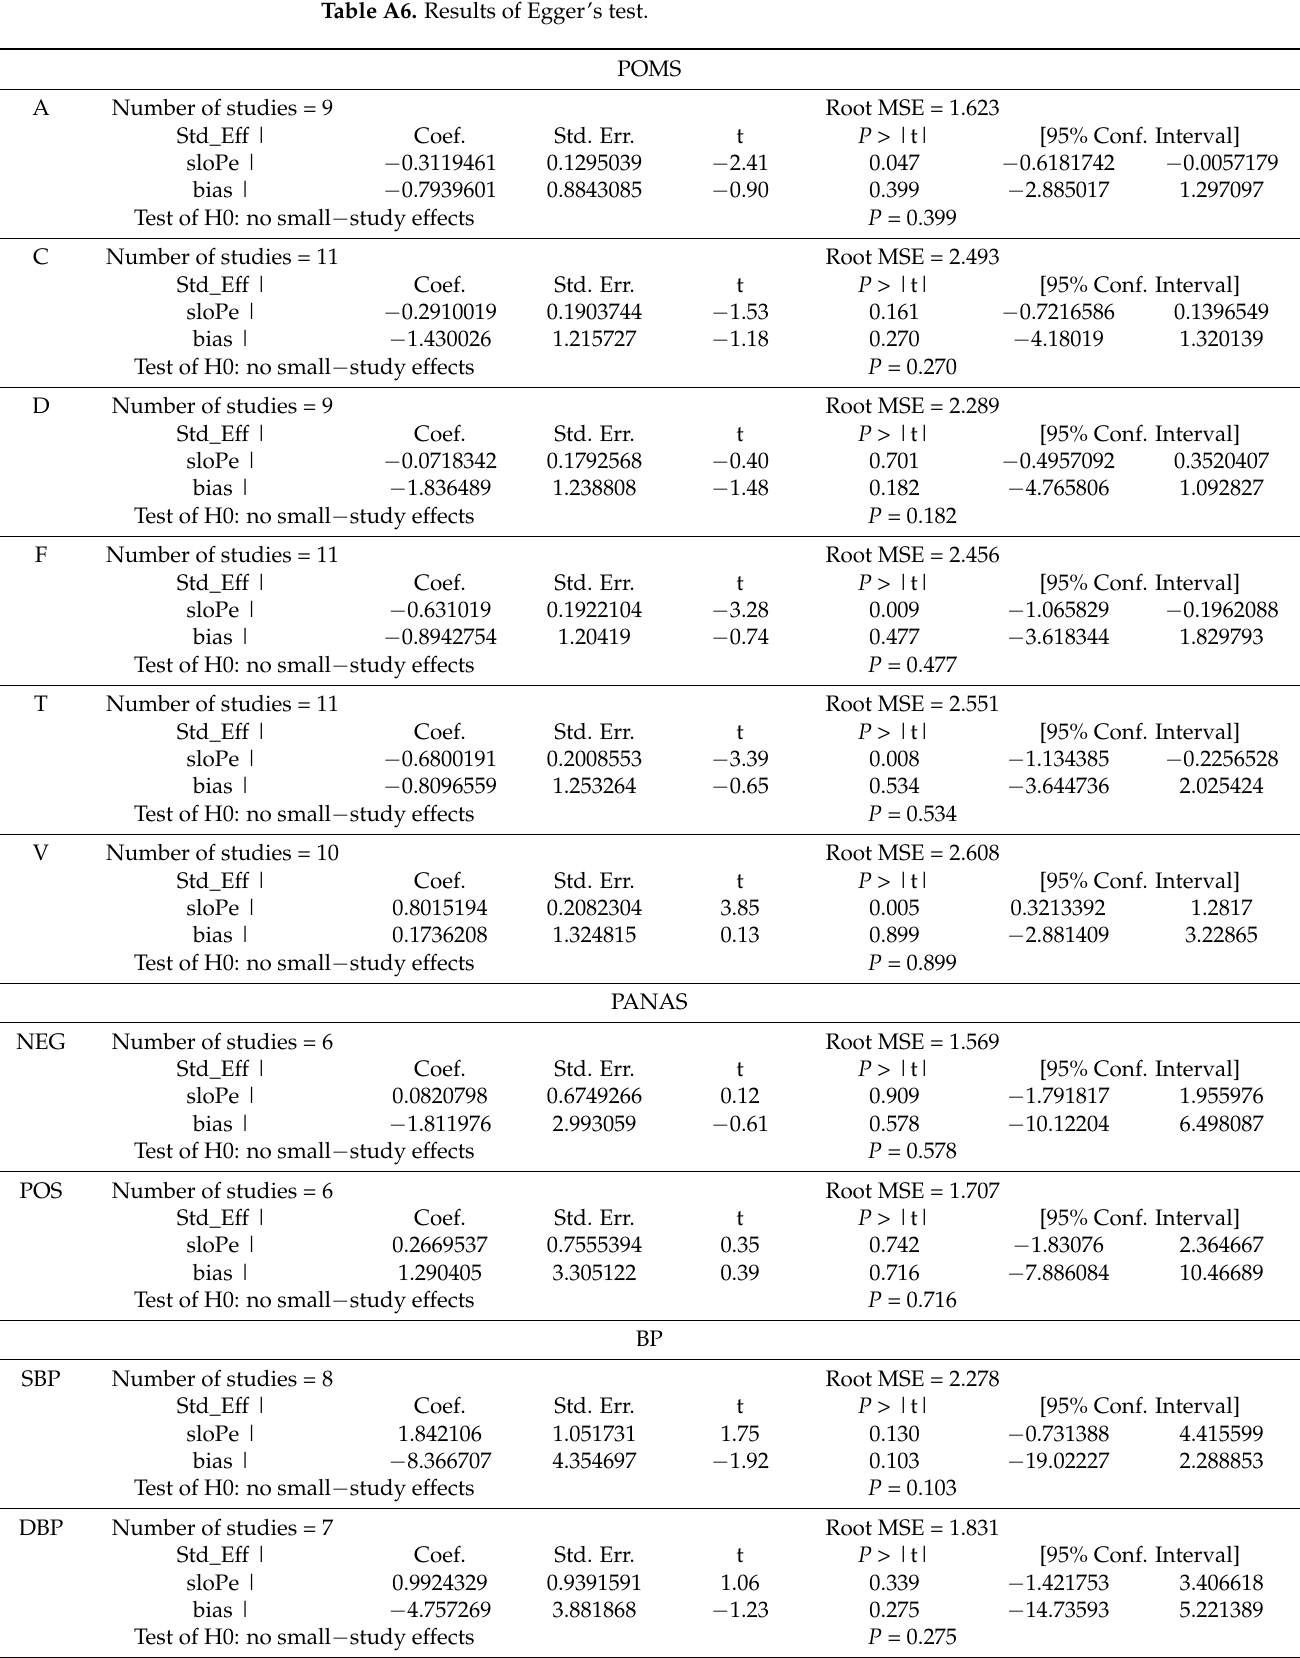
Table A6. Results of Egger’s